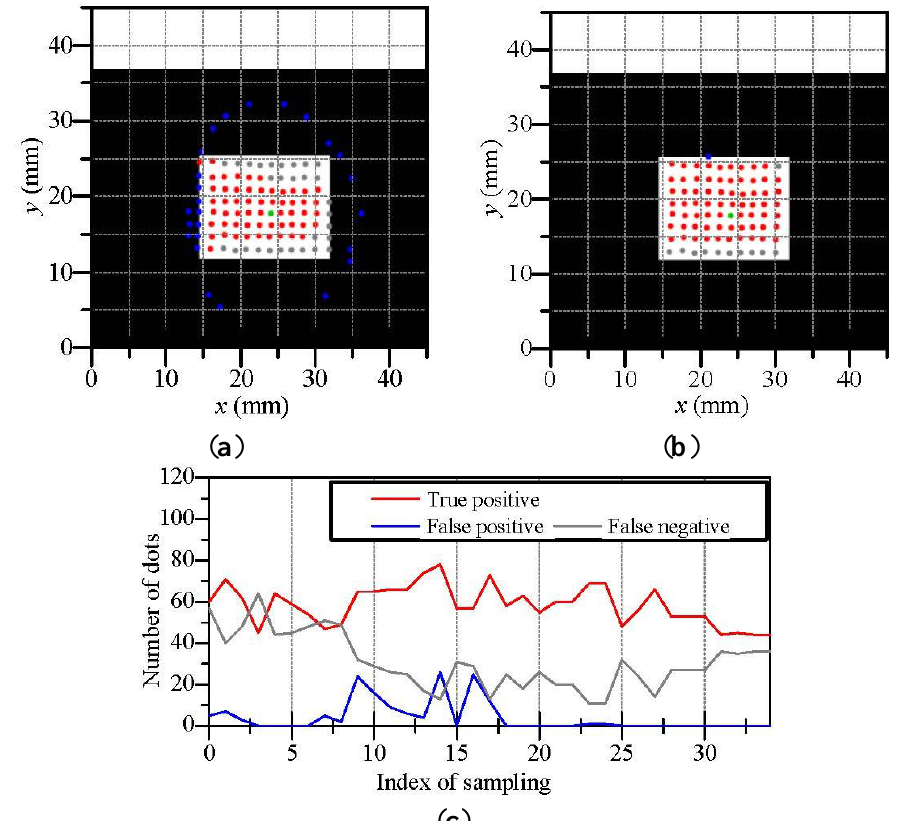
Figure 8. The estimation result of contact region when the touchpad contacted a rectangular object; ( a ) is a worse case; ( b ) is a better case; ( c ) is the variation of the estimation when the contact became increasingly